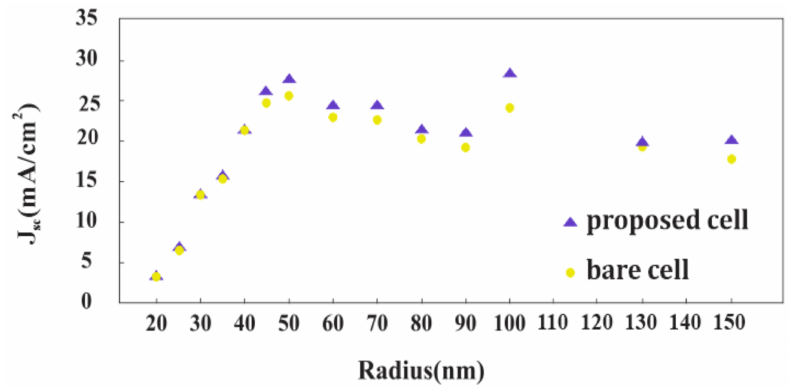
Figure 6. The short circuit current density (in mA/cm 2 ) of the bare and proposed cell of InP NW array solar cell for varying radius.